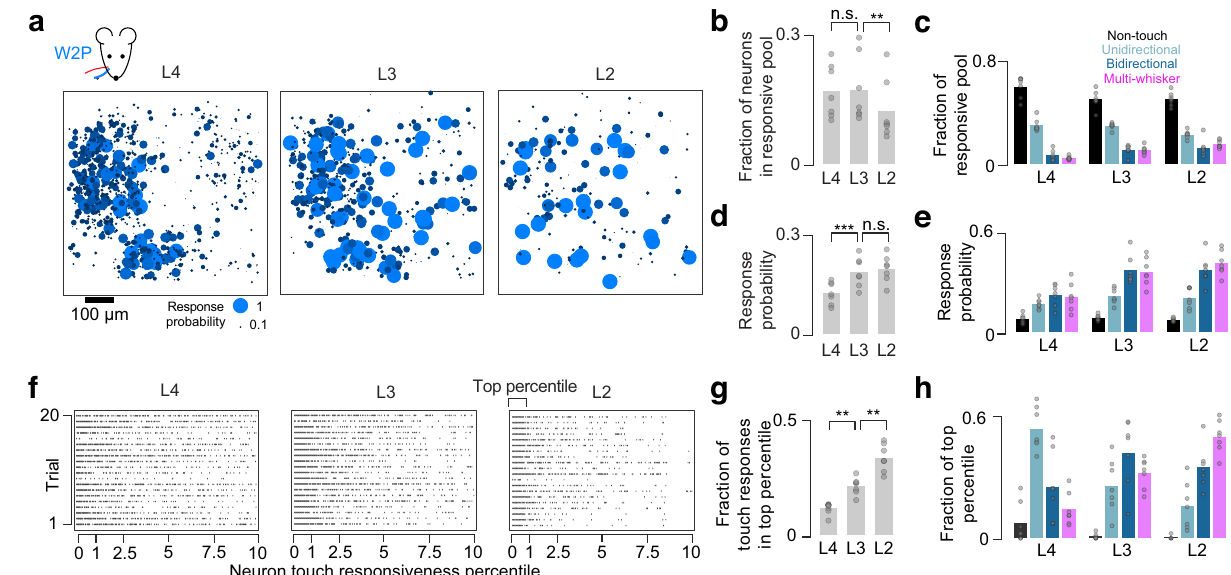
Fig. 4 | Transition to sparser, more reliable responses from L4 to L2. a Population response to strong W2P touches across layers. Ball size and color indicate response probability(Methods).Allneuronsforalayerareprojected onto a single plane. b Fraction of neurons responding to strong W1P or W2P touches across layers( ‘ responsive pool ’ ; Methods; mean, n =7 mice). P -values indicatedfor paired t -test, * p <0.05, ** p <0.01, *** p<0.001, n.s not signi fi cant. c Fractional com- position of the responsive pool in each layer by touch neuron type. d Response probability across layers for neurons in this responsive pool (mean, n =7 mice).